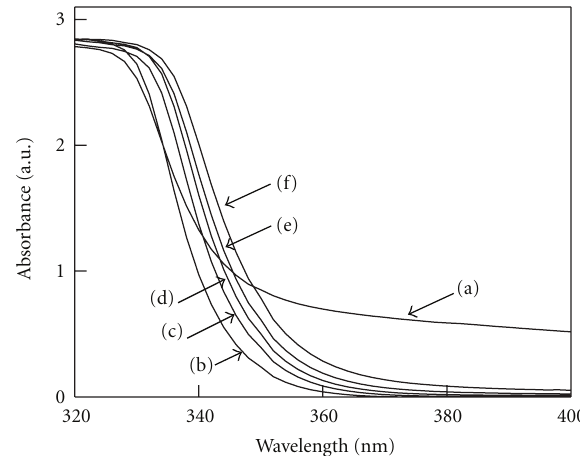
Figure 5: UV-VIS absorption spectra of the mixture of ethyleneg- lycol solution of TIP and NH 3 (aq) ([NH 3 ] = 1 mol/L). The heating temperature was 368 K. The heating times were the following: (a) 0h (before heating), (b) 1h, (c) 3h, (d) 6h, (e) 12 h, and (f) 24 h.